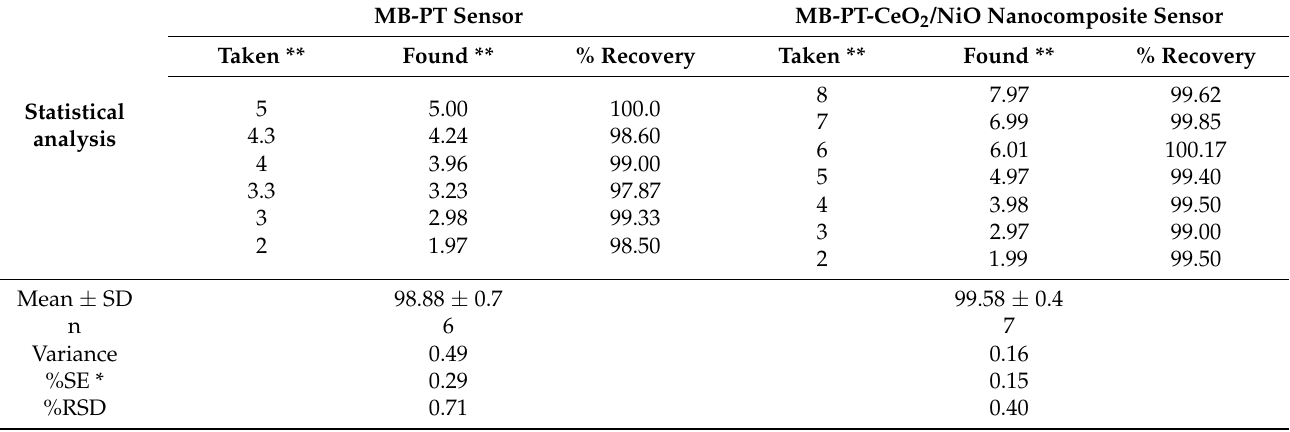
Table 3. The resulting data estimated from the utilization of MB-PT and MB-PT-CeO 2 /NiO nanocom- posites for the quantification of MB in its authentic